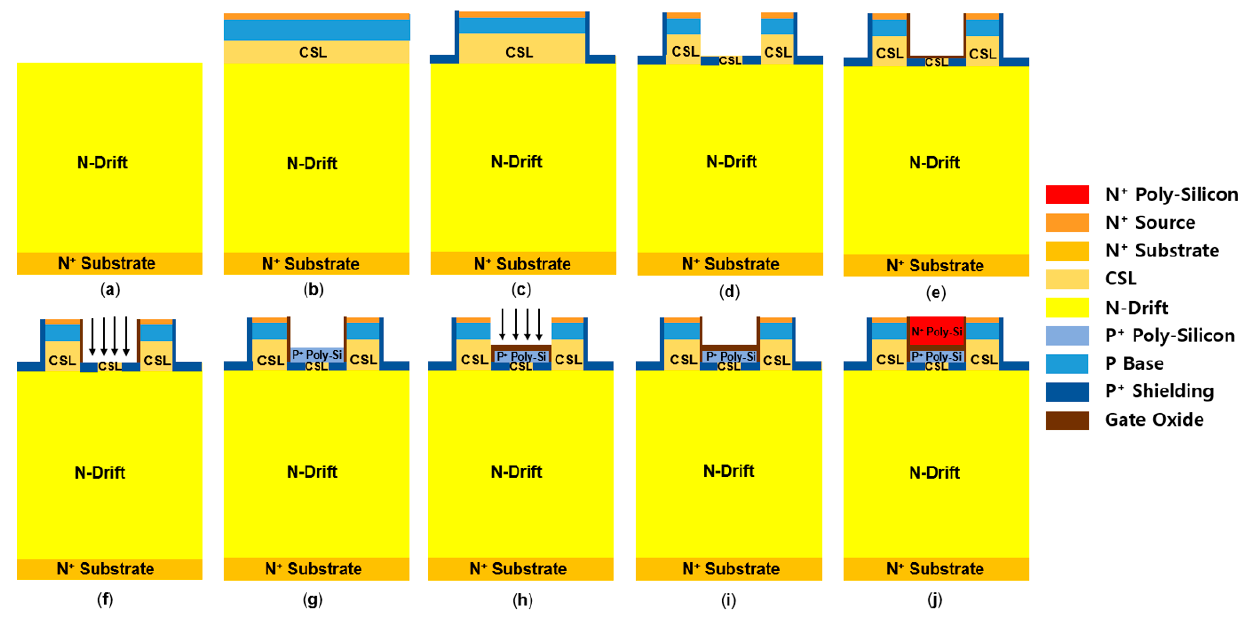
Figure 10. Proposed fabrication process of SHG-DTMOS. ( a ) Epitaxial N-drift layer on N + substrate. ( b ) Form the CSL by epitaxial growth and form the P base region and N + source region by double implantation. ( c ) Trench source region and P + tilt ion implantation. ( d ) Trench gate region and form the separate P + gate shielding region by ion implantation. ( e ) Thermal oxidation to form gate oxide. ( f ) Etch the bottom gate oxide by RIE-ICP etching. ( g ) Deposit P + polysilicon and etch using the etch-back process and RIE-ICP. ( h ) Deposit oxide by CVD and etch the oxide. ( i ) Form sidewall gate oxide by dry thermal oxidation. ( j ) Deposit N + polysilicon and etch